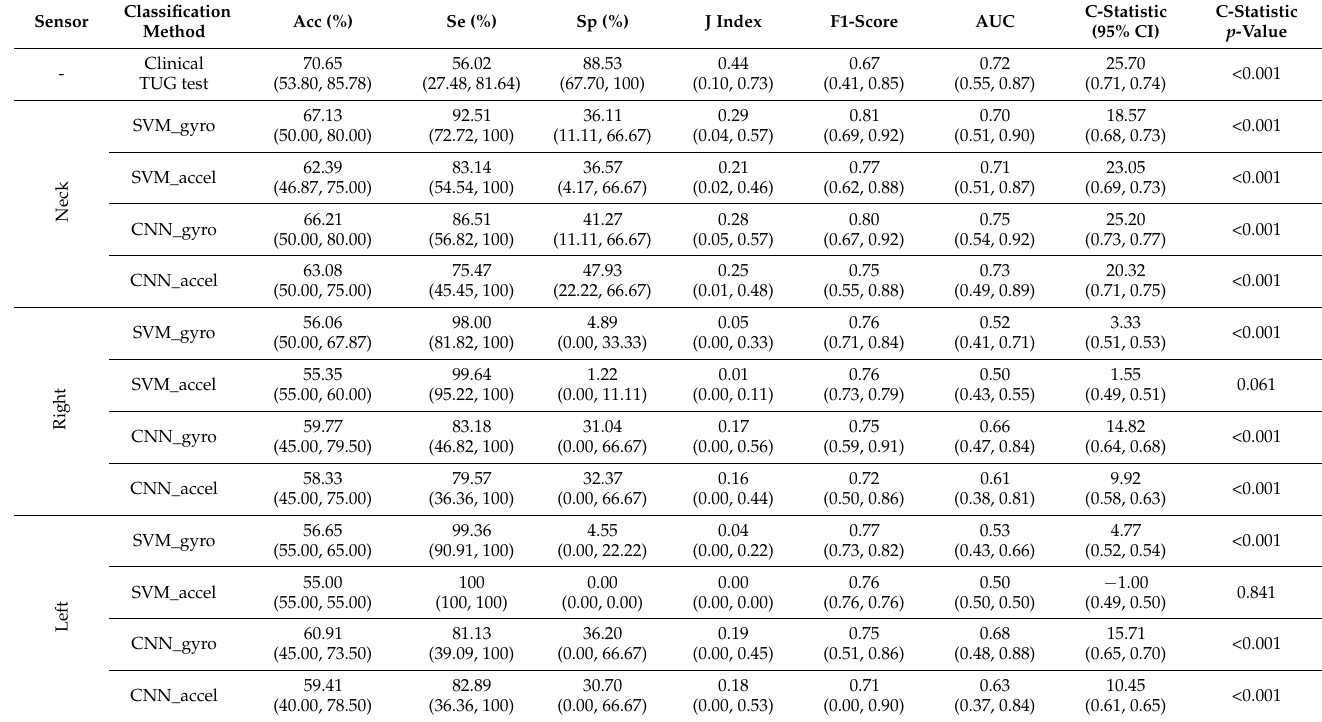
Table 4. Fall-risk classification of geriatrician’s fall assessment using ML with the kinematics measures of the TUG test and comparison with traditional clinical TUG